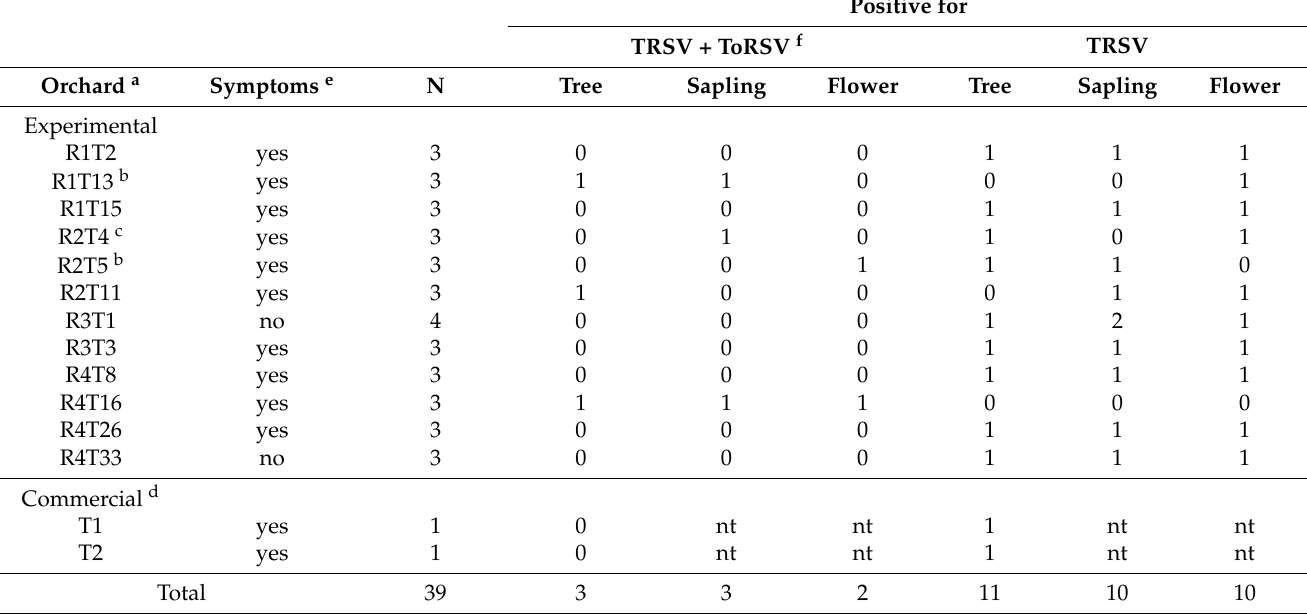
Table 3. Detection of tobacco ringspot virus (TRSV) and tomato ringspot virus (ToRSV) by RT-PCR and DAS-ELISA in leaves or flowers of pawpaw trees and saplings collected from an experimental orchard and a commercial orchard. Positive for TRSV + ToRSV f TRSV Tree Sapling Flower Tree Sapling